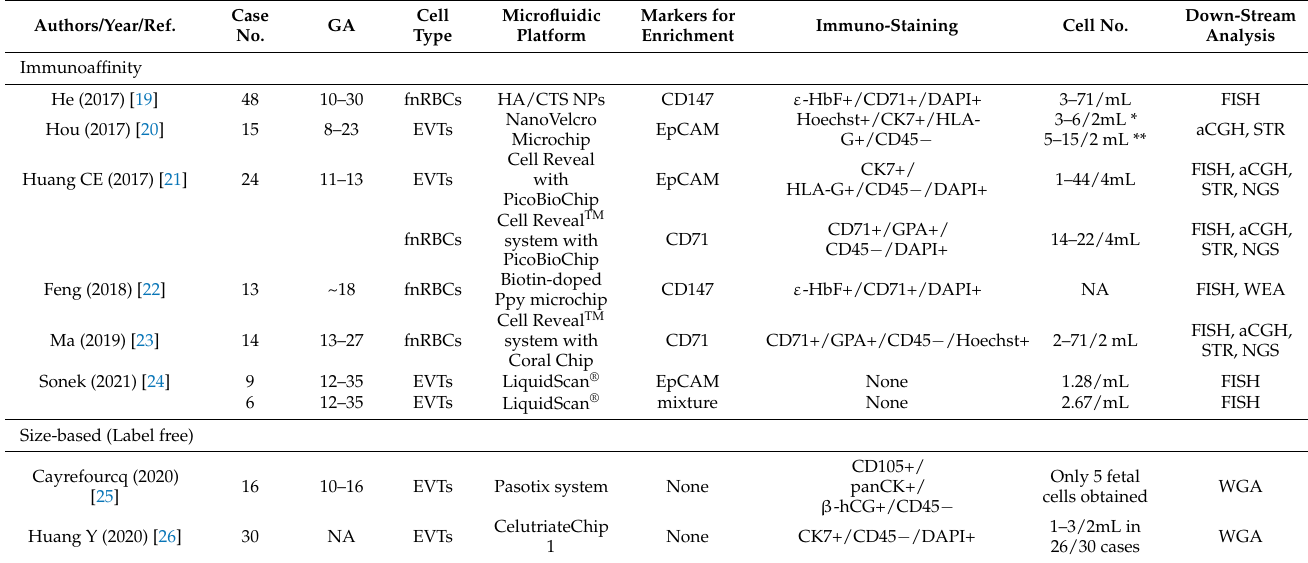
Table 1. A summary of microfluidic technical approaches for detection and isolation of fetal cells from maternal peripheral